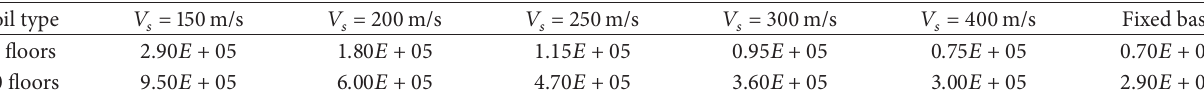
Table 2: The total amount of viscoelastic material C 𝑇 for optimal design.